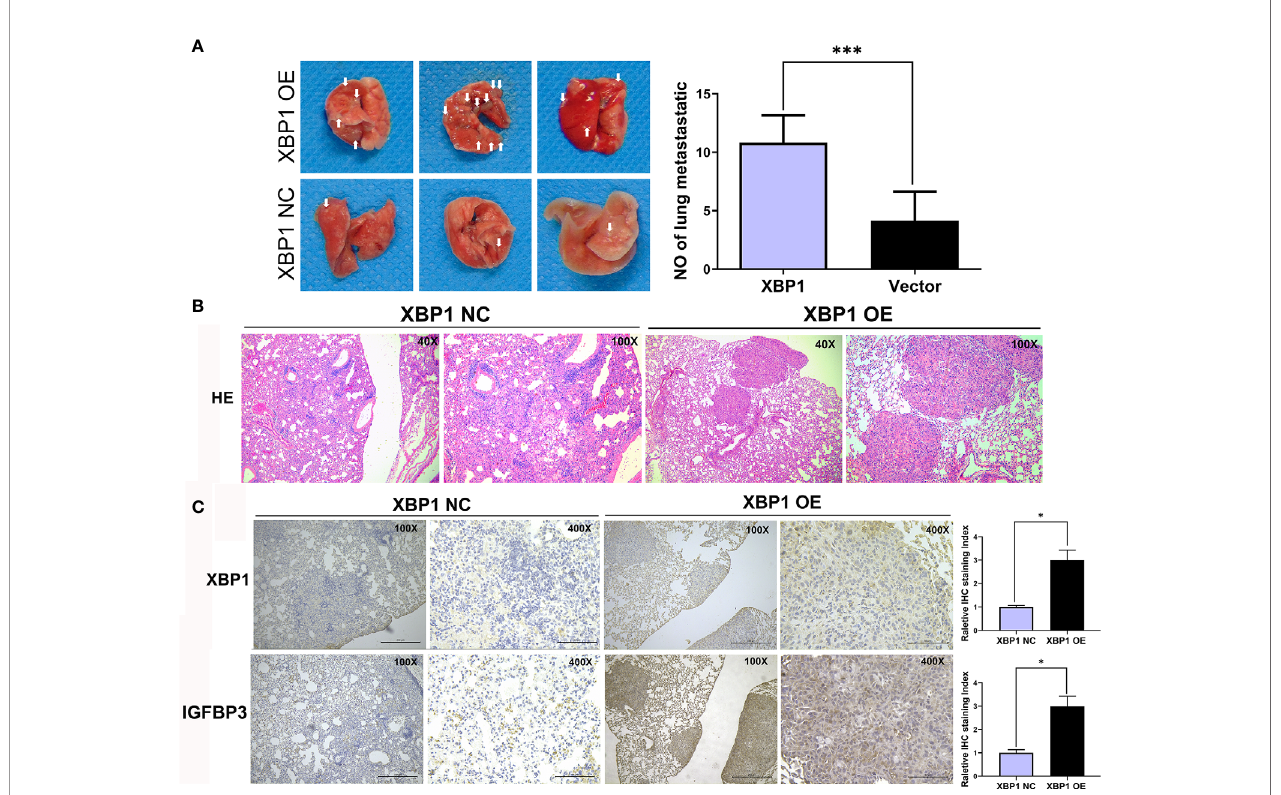
FIGURE 4 | XBP1 overexpression promotes proliferation and metastasis in vivo . (A) Relative photographs of gross lungs with arrows pointing to lung surface tumor nodules from the i.v. metastasis assay. (B) H&E stained section of lung metastasis nodules. With original magni fi cation: X4, X10 are shown. (C) Relative immunohistochemically stained images of lung tissues using anti-XBP1 and anti-IGFBP3. Data were represented as the mean ± SEM of three independent experiments. * P < 0.05, *** P <